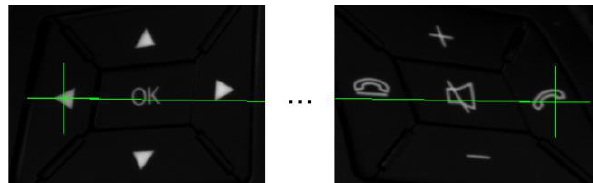
Figure 6. Two extracted points (one in the left field of multifunctional buttons and one in the right field) and their connecting straight line